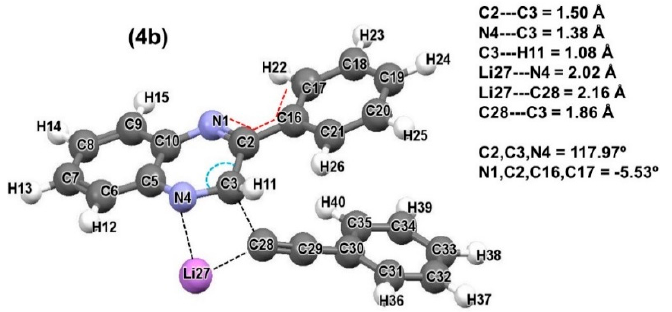
Figure 4. Energy‑optimized electronic structure of transition state 4b . Important distances, angles, and dihedral angles are given in Å and °, respectively.